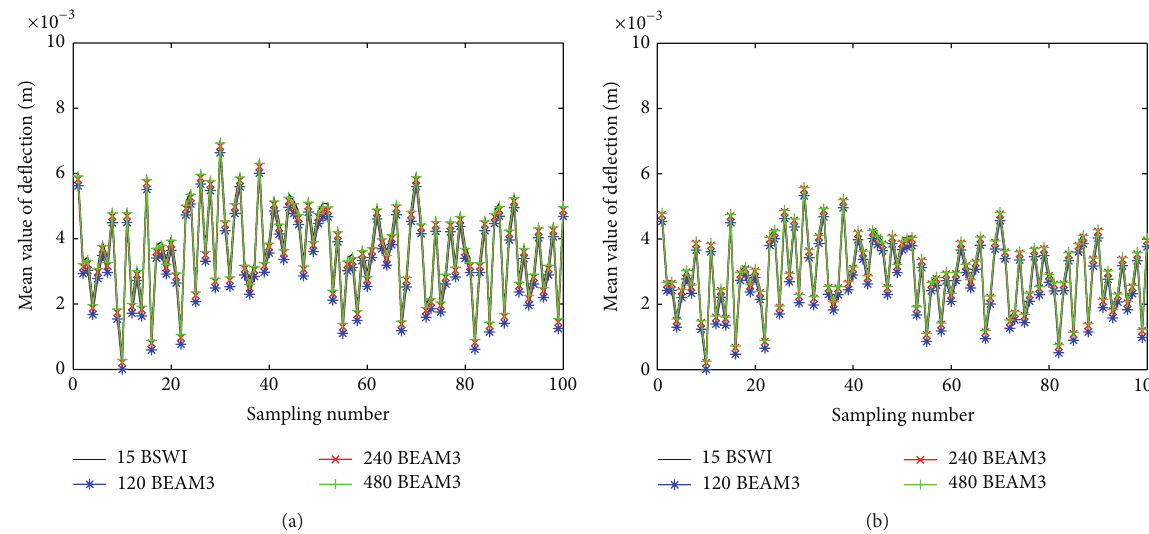
Figure 16: Relationship between the bending analysis results and sampling number of the plane rigid frame. (a) Point A and (b) point B.